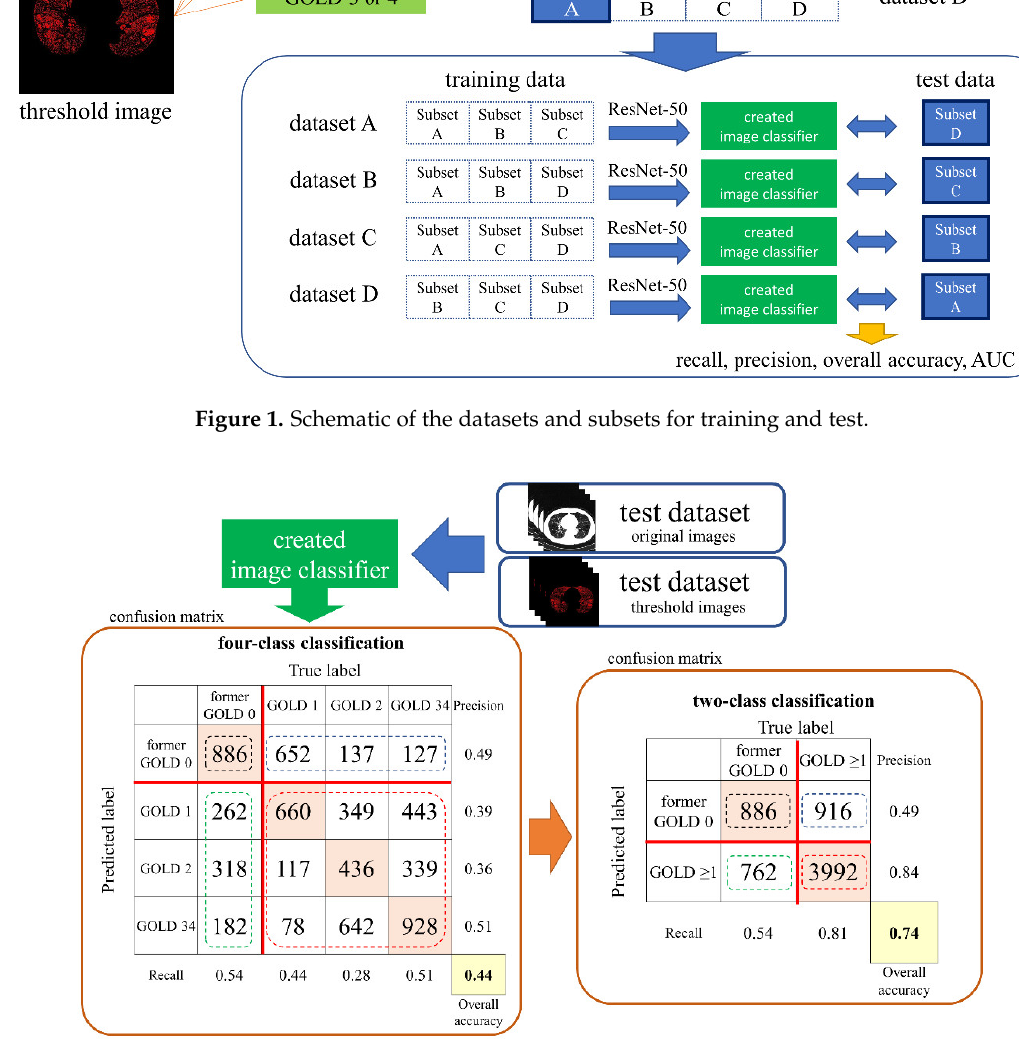
Figure 2. Confusion matrix for evaluating the recall, precision, and overall accuracy.